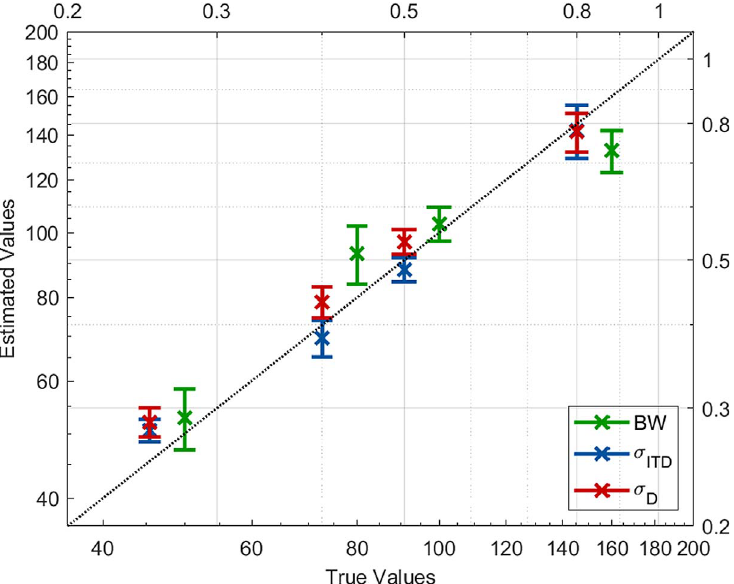
Figure 6. Final estimates of the internal parameters of the arti fi cial test subject using 64 different parameter combinations. The results of the individual parameters are presented using a 95% con fi dence interval. Note that the resolutions of the 3 parameter values are the same, but to obtain better readability, the abscissa for the bandwidth is shown in an abbreviated